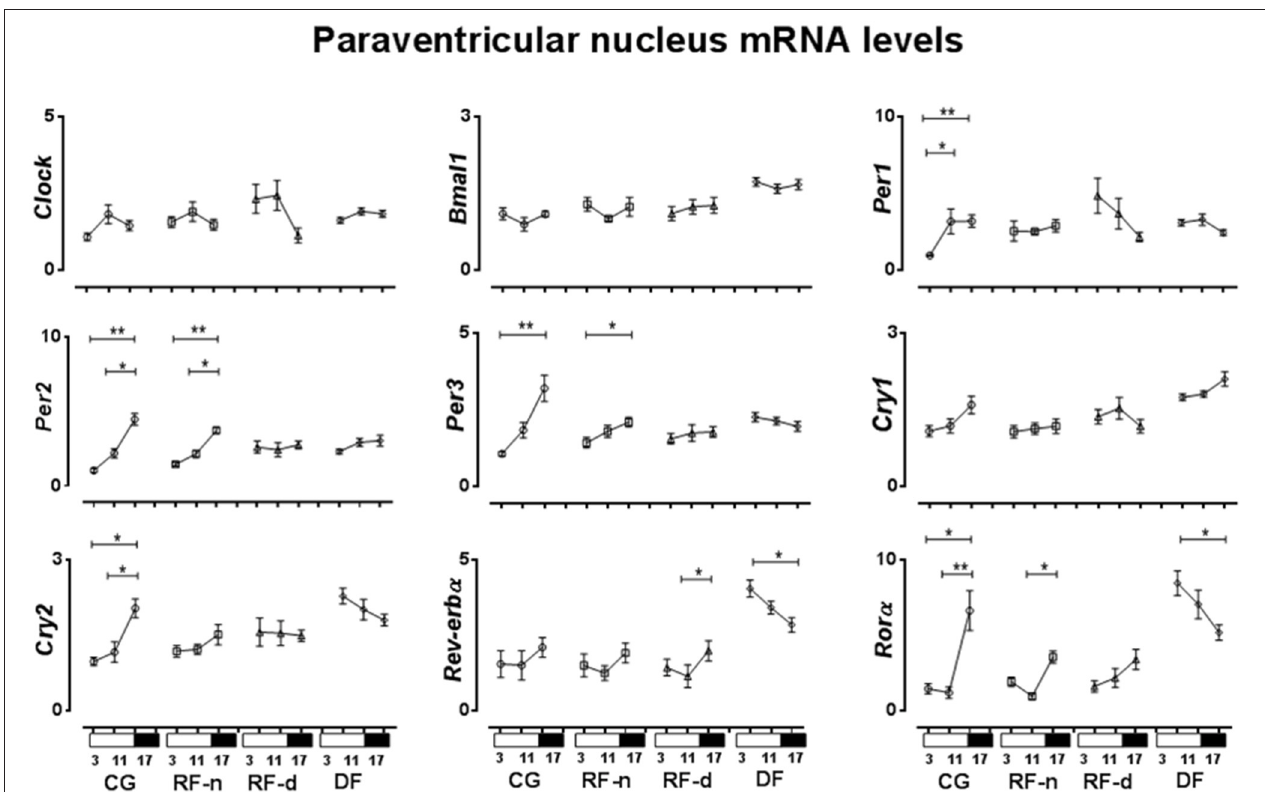
FIGURE 4 | Relative expression of clock genes in Paraventricular nucleus (PVN) in the control group, with food ad libitum ; restricted night-fed group (RF-night), with access to food restricted to ZT12 to ZT14 (1800–2000h); restricted day-fed group (RF-day), with access to food restricted to ZT3 to ZT5 (0900–1100h); and day-fed group (DF), with access to food restricted to ZT0 to ZT12 (0600–1800h) at ZT3, ZT11, and ZT17, corresponding to 0900, 1700, and 2300h; respectively. N = 6–10 rats per time point per group. ZT, Zeitgeber Time. Significant difference among ZTs within the same feeding condition: * P < 0.05, ** P <